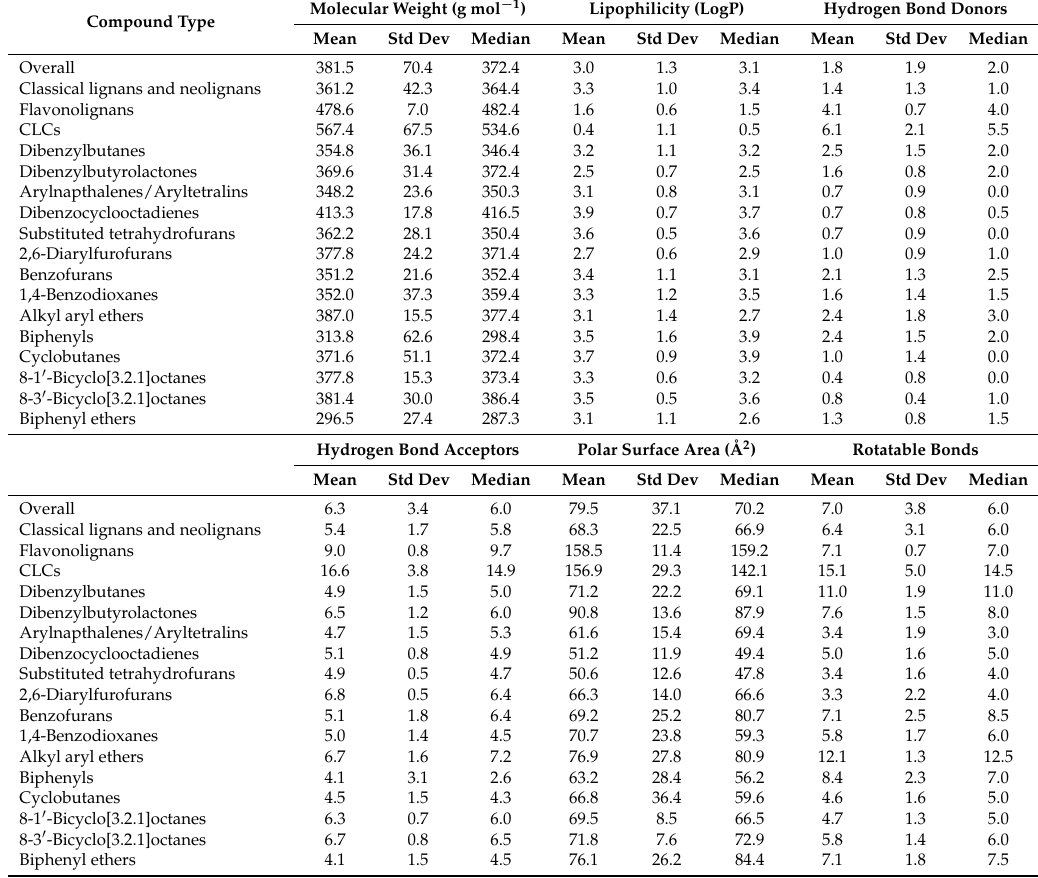
Table 2. Mean, standard deviation (std dev) and median values of the compound types for the ten molecular descriptors analysed in this